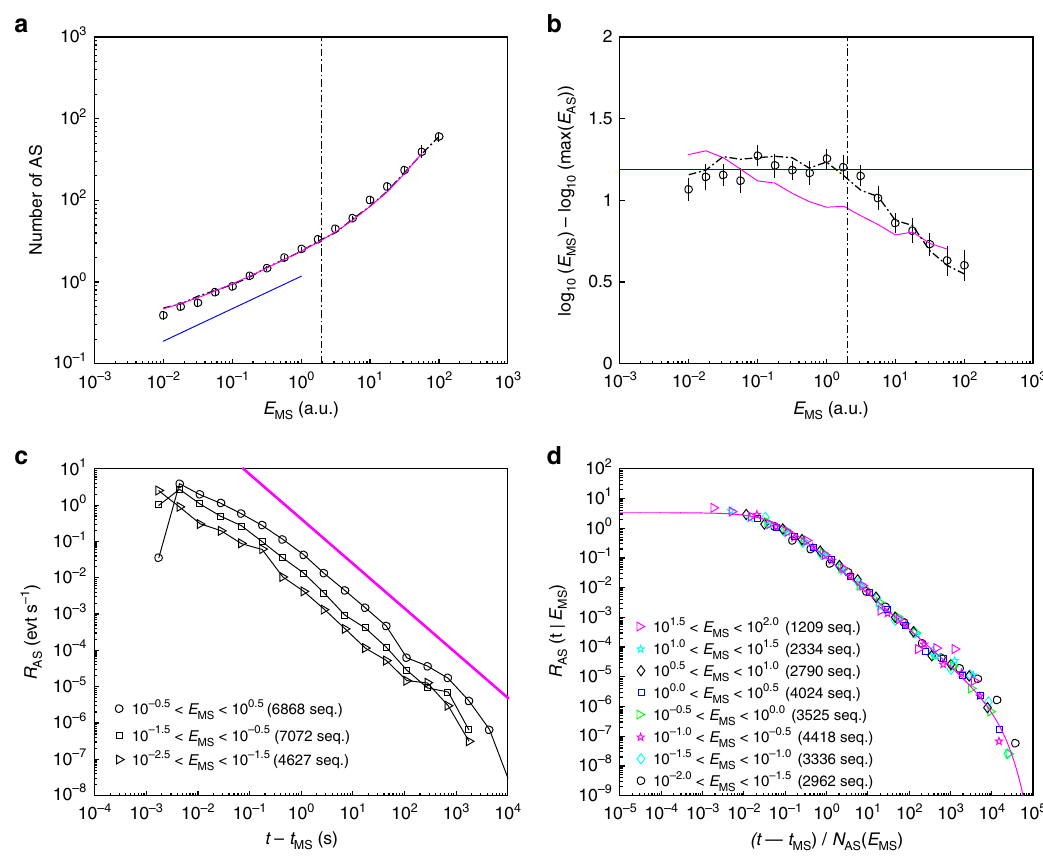
Fig. 3 Aftershock sequences and seismic laws. All axes are logarithmic. a Circles show the variations of the mean AS number, N AS , with the energy, E MS , of the triggering MS. Dash-dotted line (barely visible beneath magenta line) shows the same curve after having permuted randomly all the events and arbitrary set the time step between two successive events to unity. Productivity power-law (straight blue line) is observed for E MS < E c = 2 (vertical dotted line). Magenta line is the curve predicted by Eq. 3 where the cumulative distribution F ( E ) is the one measured in this experiment (integral of the curve E presented in Fig. 2a). b Mean magnitude difference, Δ M ¼ log MS (cid:2) max ð log 10 E AS Þ , between the MS and its largest AS as a function of the MS energy. 10 As in (a), circles show the experimental data while the dashed-dotted line shows that obtained after random permutation and setting time step arbitrary to unity. The error bars stand for 95% con fi dence interval. The plateau expected from Båth ’ s law (horizontal blue line) is observed for E MS < E c = 2 (vertical dotted line). Its fi tted value is Δ M = 1.19 ± 0.05. The magenta line is the curve predicted by Supplementary Equation 10. c Number of AS per unit time, R AS , as a function of elapsed time since the MS occurrence, t − t MS . Sequences have been sorted according to the MS energy as indicated in the legend. The magenta straight line indicates the Omori – Utsu power-law decay with a fi tted exponent p = 1.2 ± 0.09. d Rescaled Omori – Utsu plot R AS ( t | R MS ) as a function of ( t − t MS )/ N AS ( E MS ) where N AS ( E MS ) is given by Eq. 3. Note the perfect collapse of all curves, over all the accessible range in E MS . The magenta line is a fi t according to Eq. 4 with p = 1.18 ± 0.04, τ min = 0.06 ± 0.02 s, and τ 0 = 10 ± 3 ks. All panels concern the same experiment with d = 583 μ m and (cid:1)